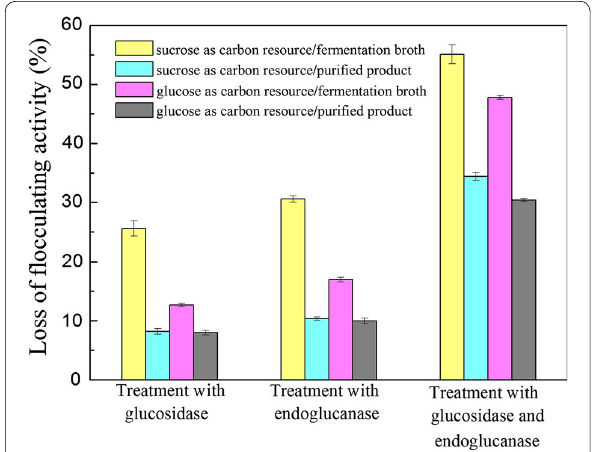
Fig. 4 The hydrolysis of polysaccharide bioflocculant by β-glucosidase and